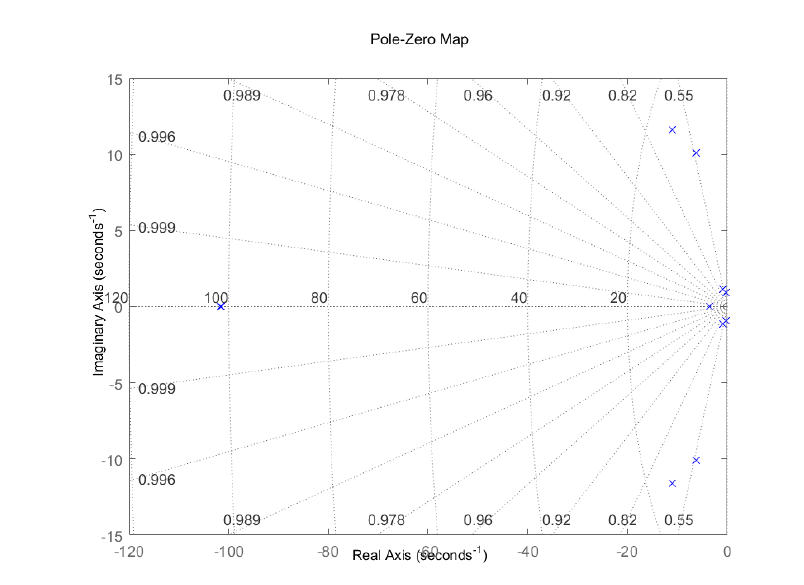
Figure 20. Pole-zero map of GA-based frequency control